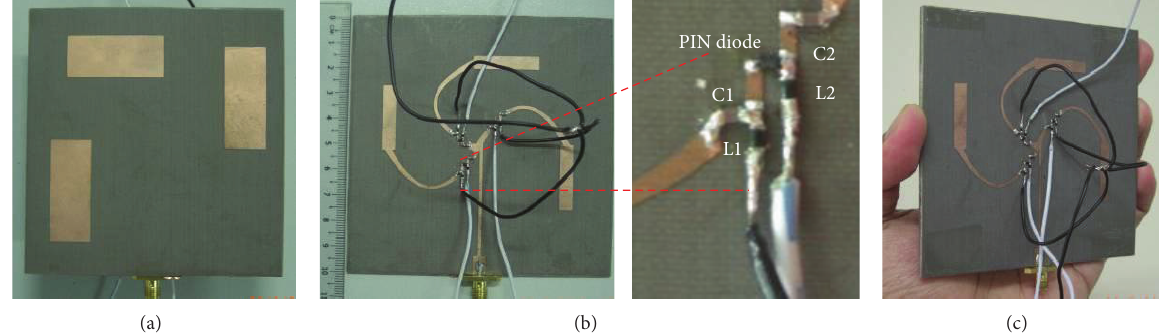
Figure 5: Geometry of the fabricatedantenna structure. (a) Radiating element surface. (b) Spiral feed network integrates with RF switches. (c) Antenna layout.